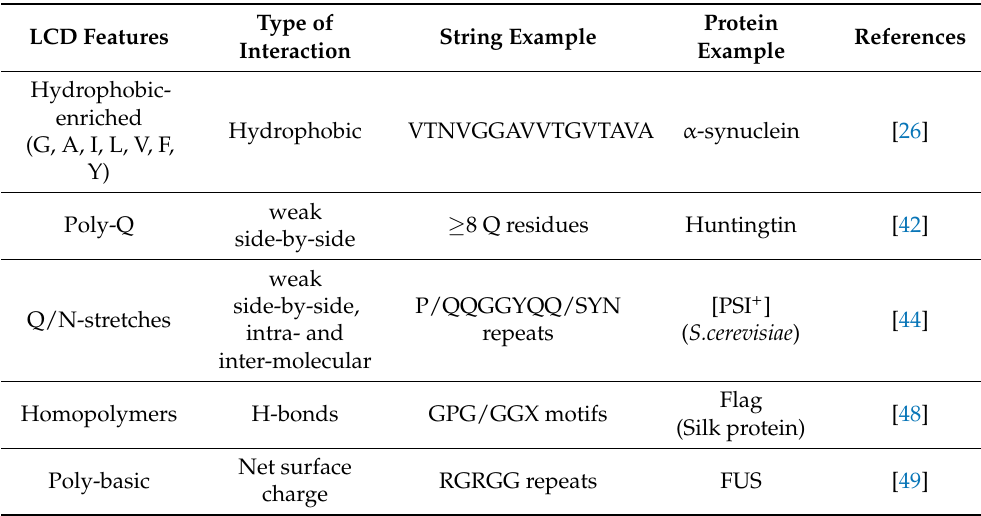
Table 1. Features and sequences of